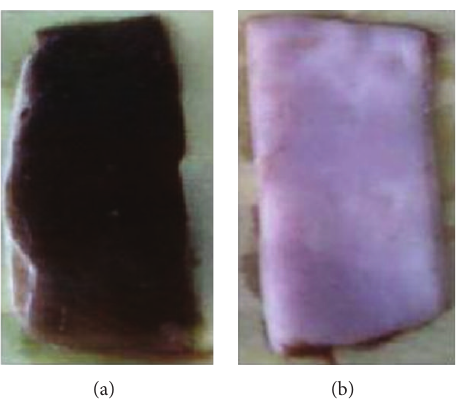
Figure 3: Dehairing of cow hide. (a) Cow hide control and (b) cow hide after 18 h incubation with CCP.